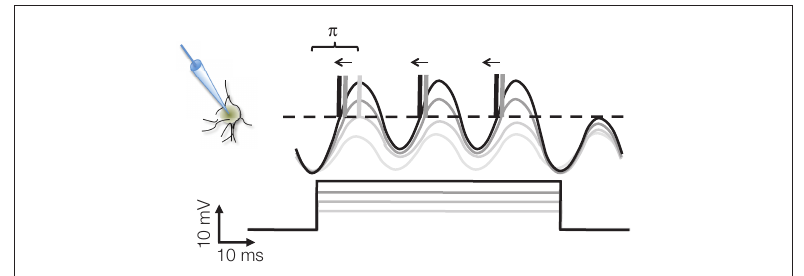
Figure 1 | The scheme of intracellular current clamp recordings from a neuron being depolarized by different levels of current injection. As the level of depolarizing current increases (gray levels), the amplitude of subthreshold membrane potential oscillation increases with it. At the moments when the oscillations reach the threshold (dashed line), the neuron generates action potentials (vertical lines represent truncated action potentials). Near the threshold the action potential generation is probabilistic. The number of action potentials (0, 1, 3, 3) increases with the level of depolarization. At the same time, with the increasing current, the phases of action potentials relative to the membrane oscillations advance (left pointing arrows). The range of the phase change is bound to π . Note that while the number of action potentials saturates at 3, the phase still advances. (Scale bar is at bottom left.)